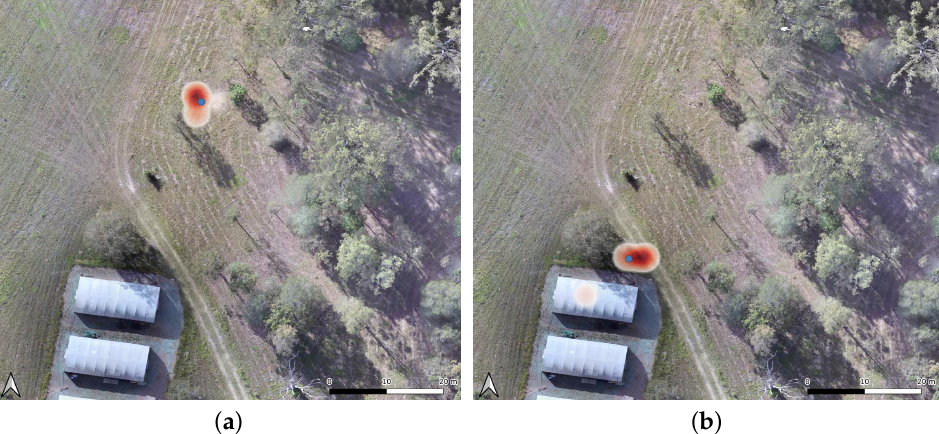
Figure 14. GNSS coordinates’ heatmaps of confirmed victim detections by the POMDP-based motion planner in offboard flight mode. ( a ) First victim location (blue dot) in an open area. ( b ) Second victim location (blue dot) nearby a tree.